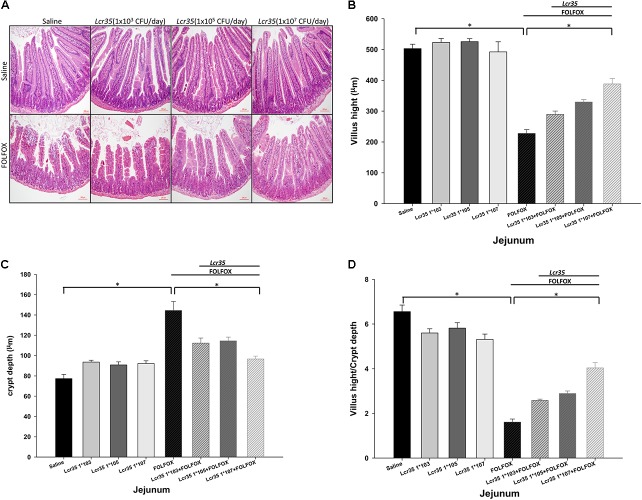
Effects of Lcr35 on histological changes in the jejunum of subcutaneously injected colorectal carcinoma mice presenting FOLFOX-induced intestinal mucositis (n = 6 for each group). Segments of the jejunum were harvested for (A) hematoxylin and eosin staining (scale bar = 100 μm) and measurement of (B) villus height, (C) crypt depth, and (D) villus height-to-crypt depth ratio per mouse. The mice received saline or Lcr35 (1 × 103-7 CFU/daily) daily during the experiment. Values are presented as the mean ± SEM. ∗p < 0.05.